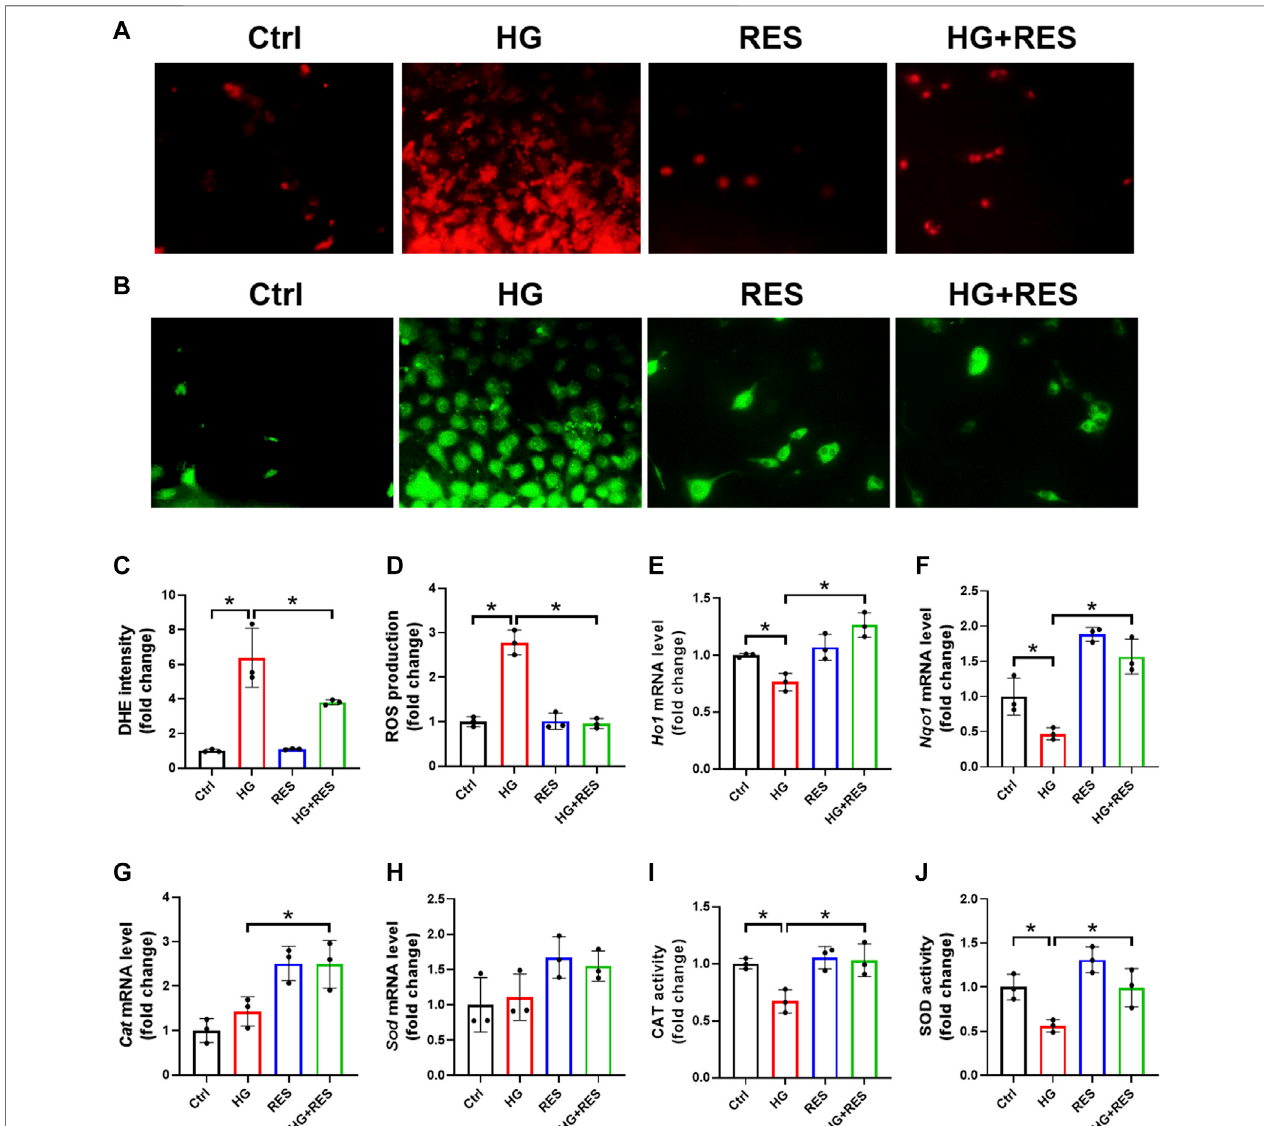
FIGURE 3 | Protective effect of RES on HG-induced oxidative stress in MC3T3-E1 cells. MC3T3-E1 cells were incubated in a basic culture medium, together with or without HG (30 mM) and RES (5 μ M) for 24 h. (A – D) Representative images of reactive oxygen species (ROS) levels determined by (A,C) DHE and (B,D) DCFH-DA staining with quanti fi cations of the respective fl uorescence intensity. Three independent experiments were performed. (E – H) Heme oxygenase 1 ( Ho1 ), NAD(P)H quinonedehydrogenase1( Nqo1 ),catalase( Cat ),andsuperoxidedismutase( Sod )mRNAlevelsweredetectedbyRT-qPCR.Threeindependentexperimentswere performed. (I,J) Detection of CAT and SOD activities. Three independent experiments were performed. Data are shown as mean ± SD. * p < 0.05.